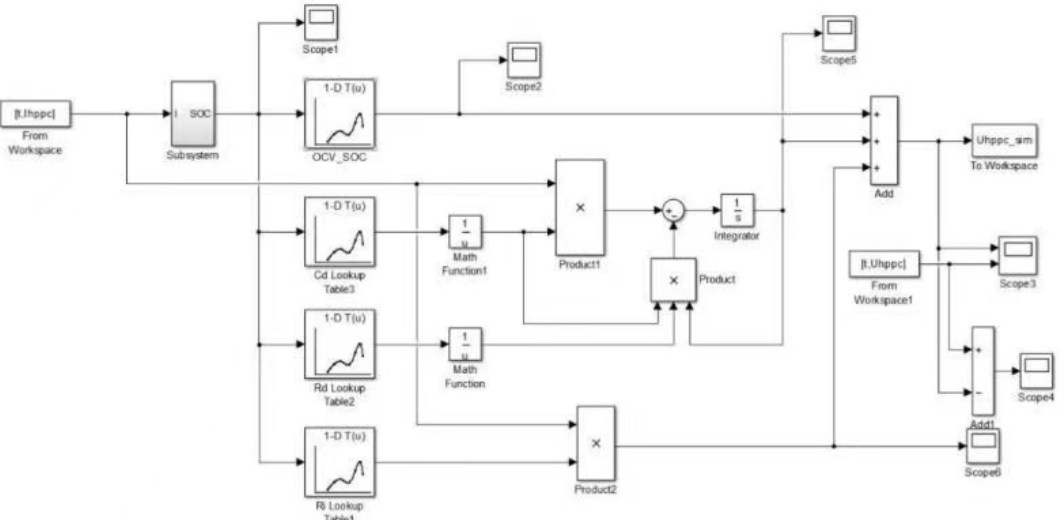
Figure 8. HyLICs Simulink model.